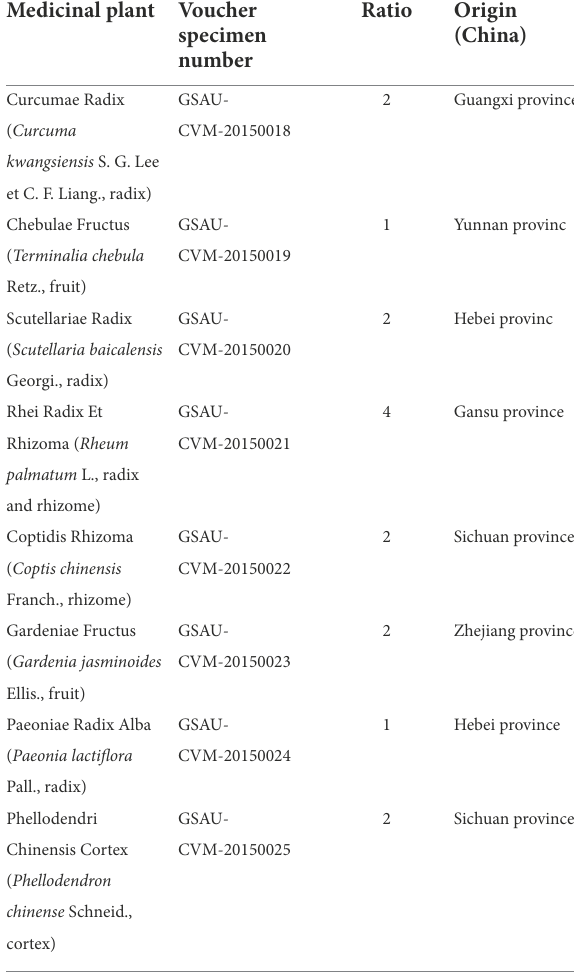
TABLE 1 Description of Yujin Powder